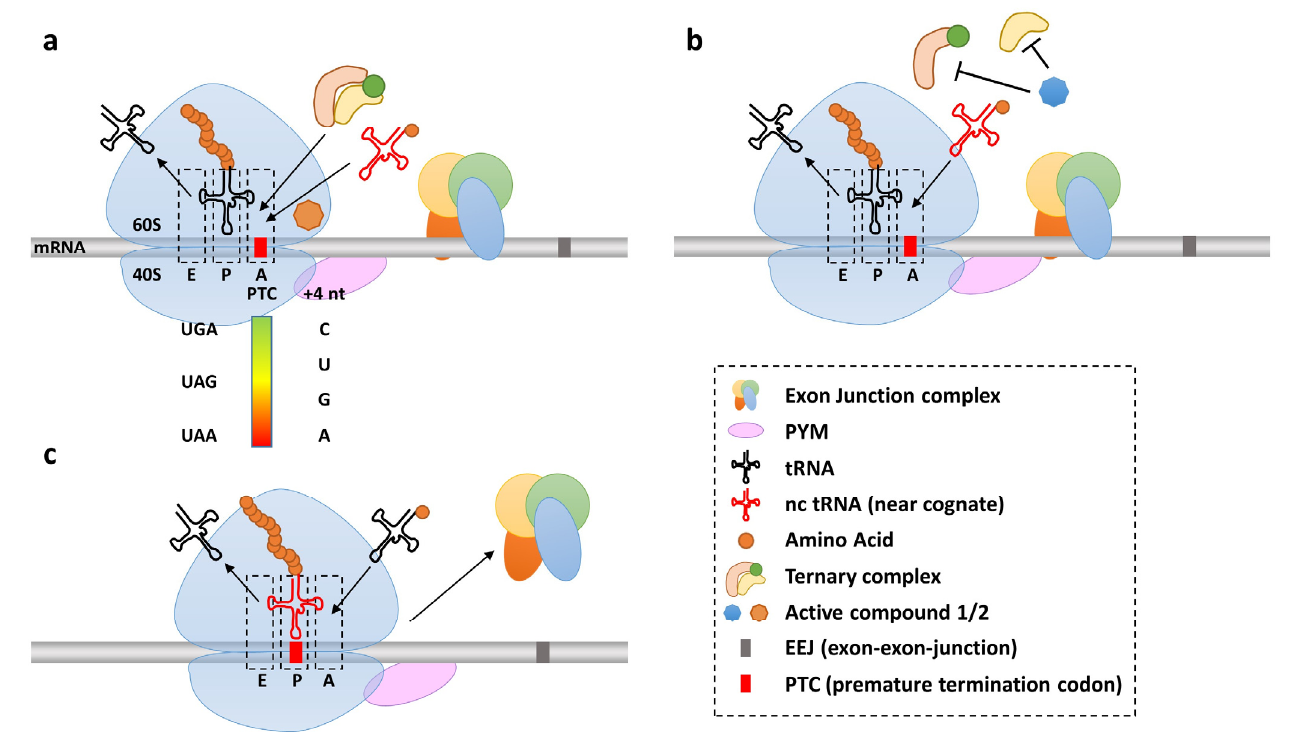
Figure 3. Mechanisms of nonsense suppression. ( a ) Aminoglycoside antibiotics (active compound 1 in orange) structurally render the A-site favorably for near-cognate-(nc-)tRNAs pairings. The competition between ternary release factor complex and an nc-tRNA is indicated. ( b ) Small molecules (active compound 2 in blue) that interfere with release factor binding increase the time frame for nc-tRNA pairing. ( c ) Ribosome incorporates an nc-tRNA at the premature termination codon, translation continues with release of the exon junction complex and without the induction of nonsense-mediated decay.